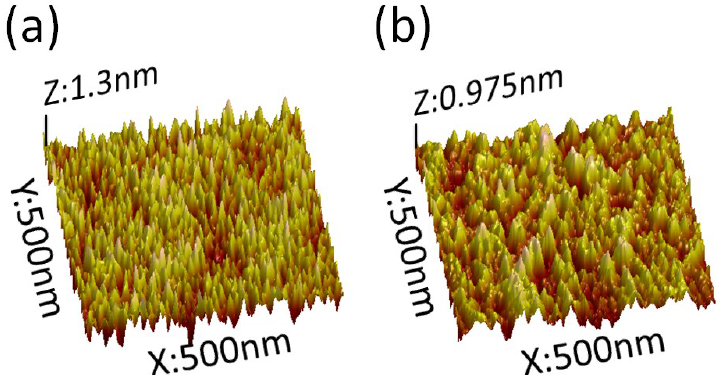
Figure 3. 3D Atomic Force Microscopy (AFM) images of Al 2 O 3 film at deposition conditions: ( a ) 80 °C, PGT = 30 s; and ( b ) 200 °C, PGT = 10 s. The scan area in AFM experiment was 1.0 μm × 1.0